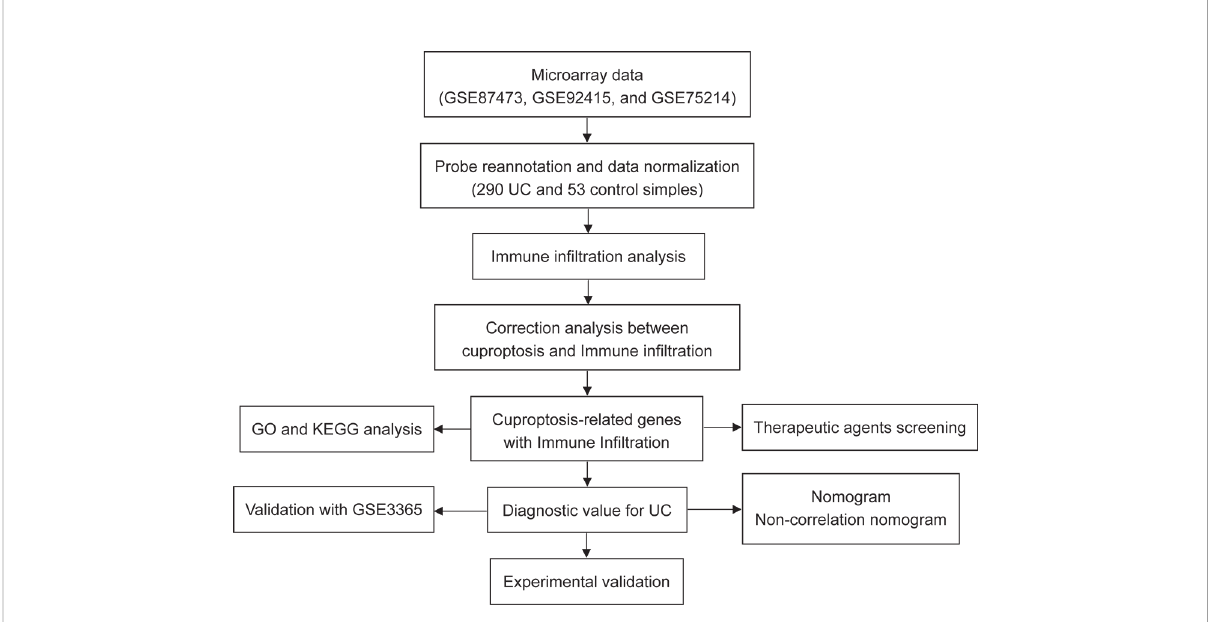
FIGURE 2 Flowchart of the present research.